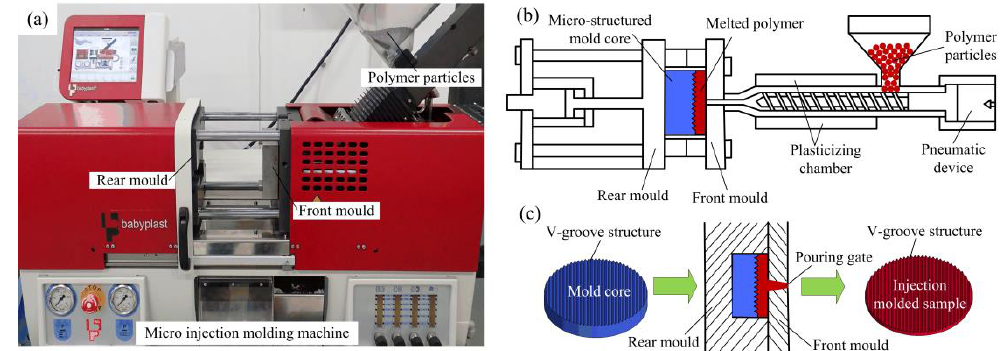
Figure 6. The micro injection molding of the micro-structured diffusion plate: ( a ) experimental photo; ( b ) schematic diagram of micro injection molding; ( c ) molding principle of the injection molded sample.